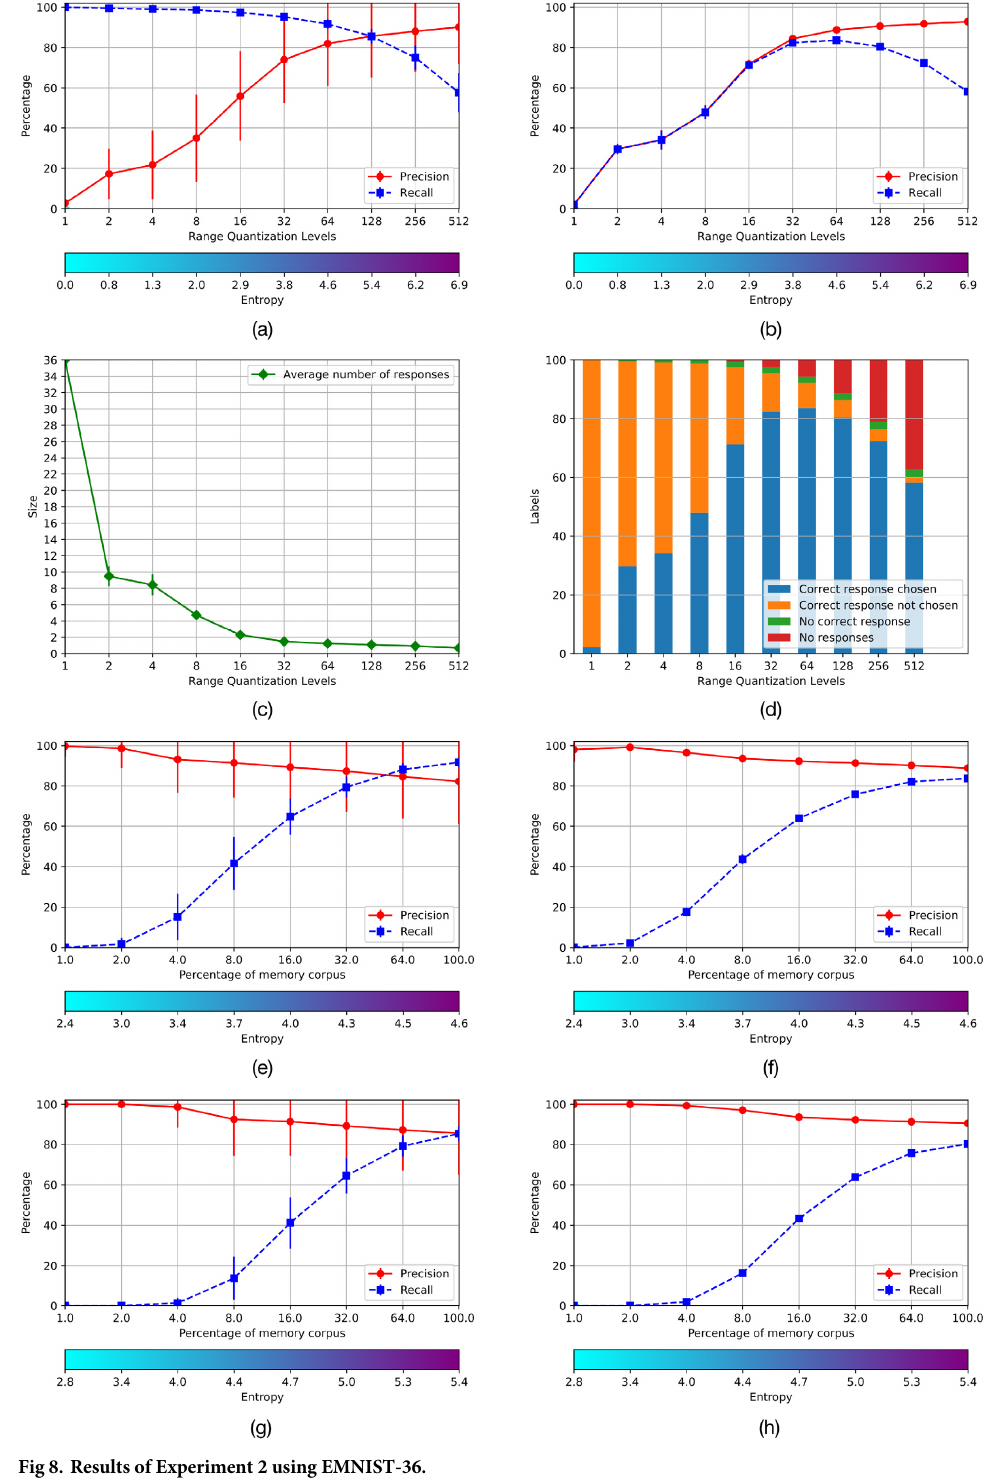
Fig 8. Results of Experiment 2 using